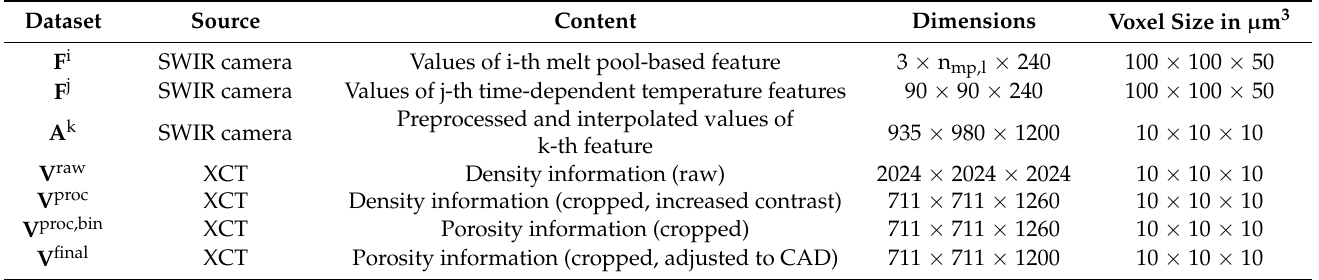
Table 3. Overview of the obtained datasets from thermography and XCT. n mp,l corresponds to the number of images acquired during the manufacturing of a single layer and is in the order of approximately 8000